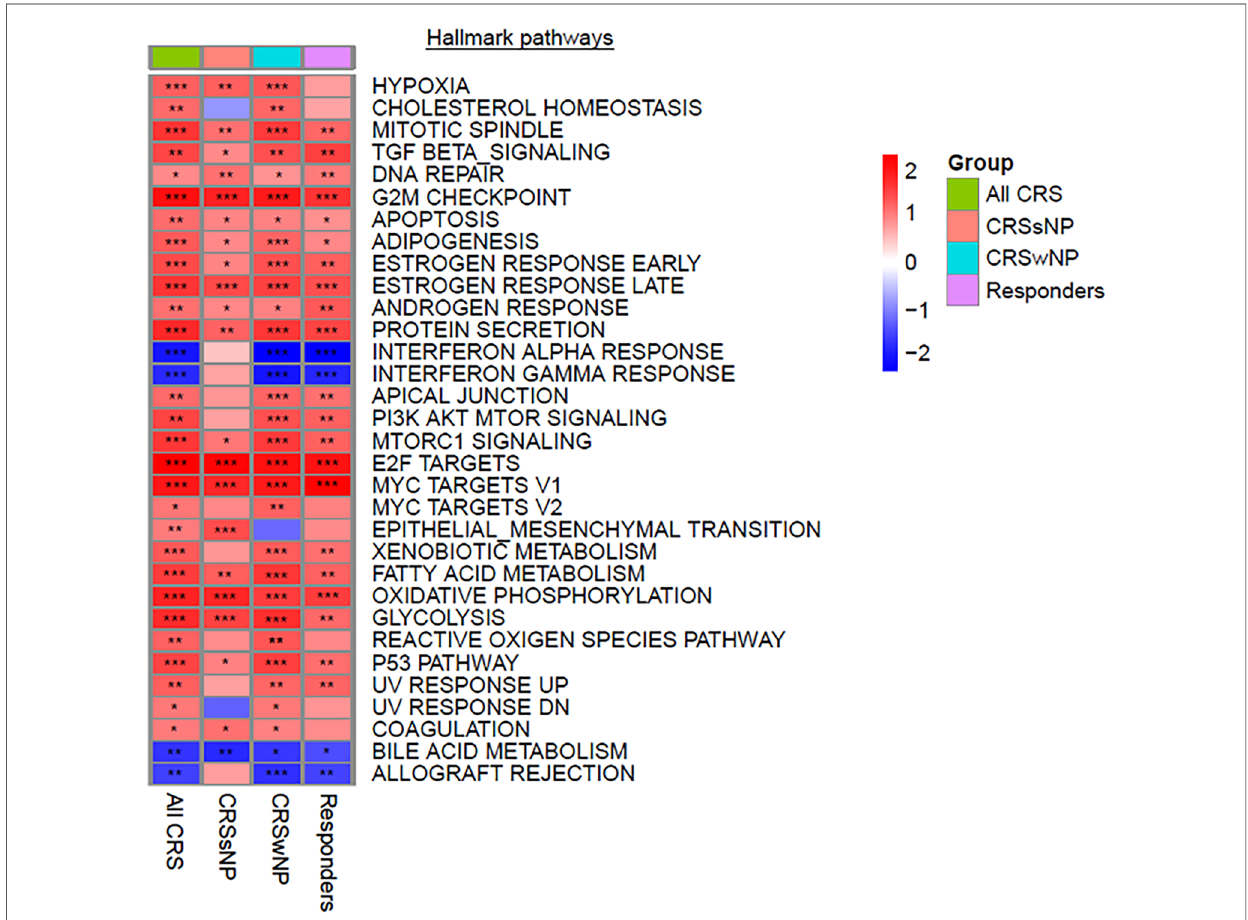
FIGURE 2 Signi fi cantly modulated pathways in both CRSwNP and CRSsNP post vs. pre-treatment with Lactococcus Lactis W136 probiotics. Heatmap of gene set expression analysis (GSEA) hallmark pathways modulated after probiotics treatment. All pathways presented have an FDR<0.05. Data is presented as normalized enrichments scores (NES) where values >0 represent upregulation and values <0 represent downregulation for each contrast. P -values are indicated by stars; * P <0.1, ** P <0.01, *** P